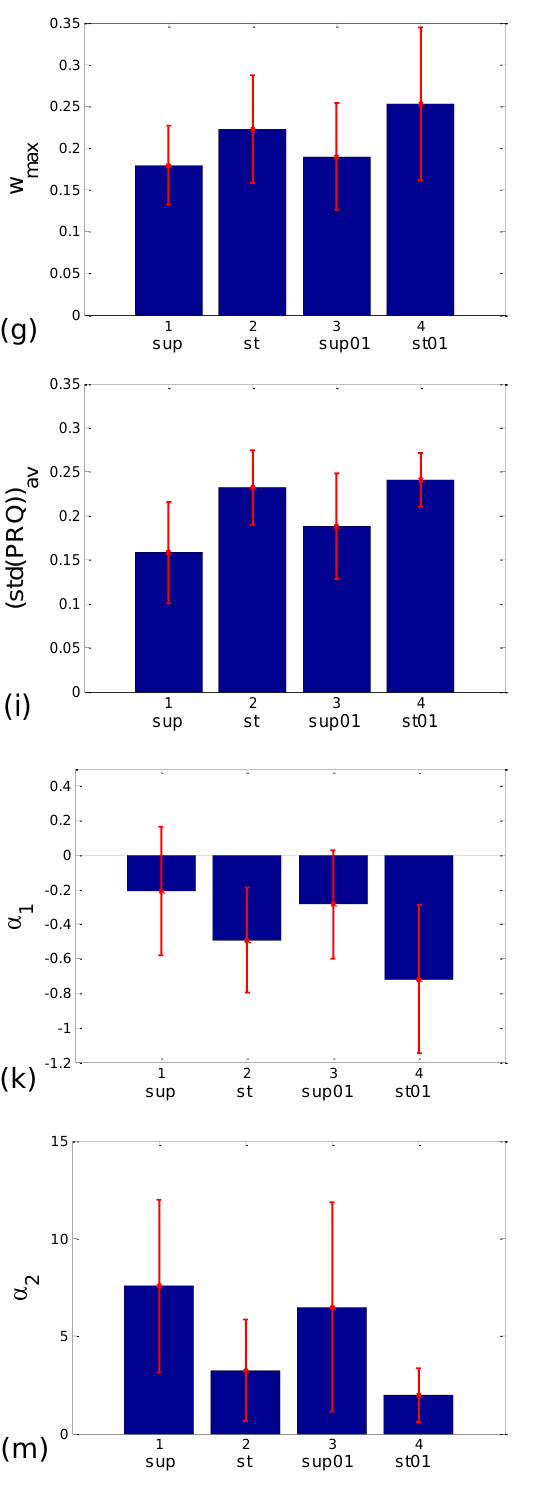
Figure 10. Bar plots showing the group mean ± standard deviation of different correlation or aggregation measures. ( a , b ) Related to BBI vs. PRQ correlations: ( a ) slopes of linear regression lines ( s l ); ( b ) Pearson’s coefficients ( r p ); ( c – n ) quantities related to BBI vs. mRRI correlations which measure the degree of aggregation of points around PRQ int lines. Left side—with respect to four states; right side—with respect to the scatter plots characterized with aggregation (AG) or a random (RD) distribution of points. The statistical test results are displayed in Table 1. Incidence histograms of the proposed six quantitative aggregation measures are presented on Figure 11.